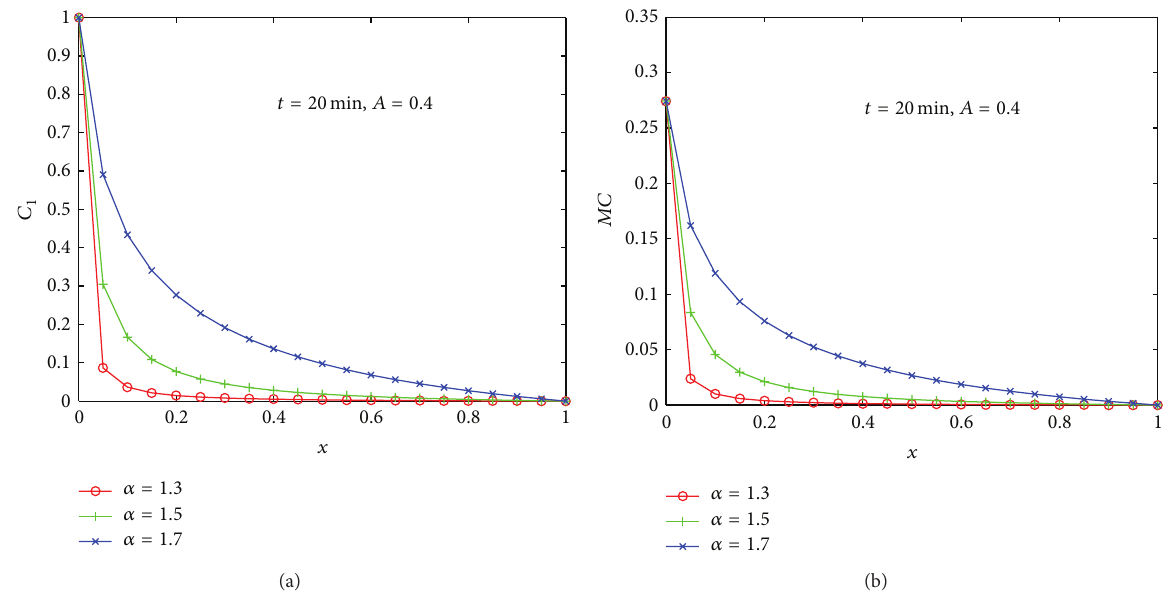
Figure 3: (a) is 𝐶 1 , plotted against 𝑥 at 𝑡 = 20 min for different values of 𝛼 ; (b) is 𝑀𝐶 , plotted against 𝑥 at 𝑡 = 20 min for different values of 𝛼 .